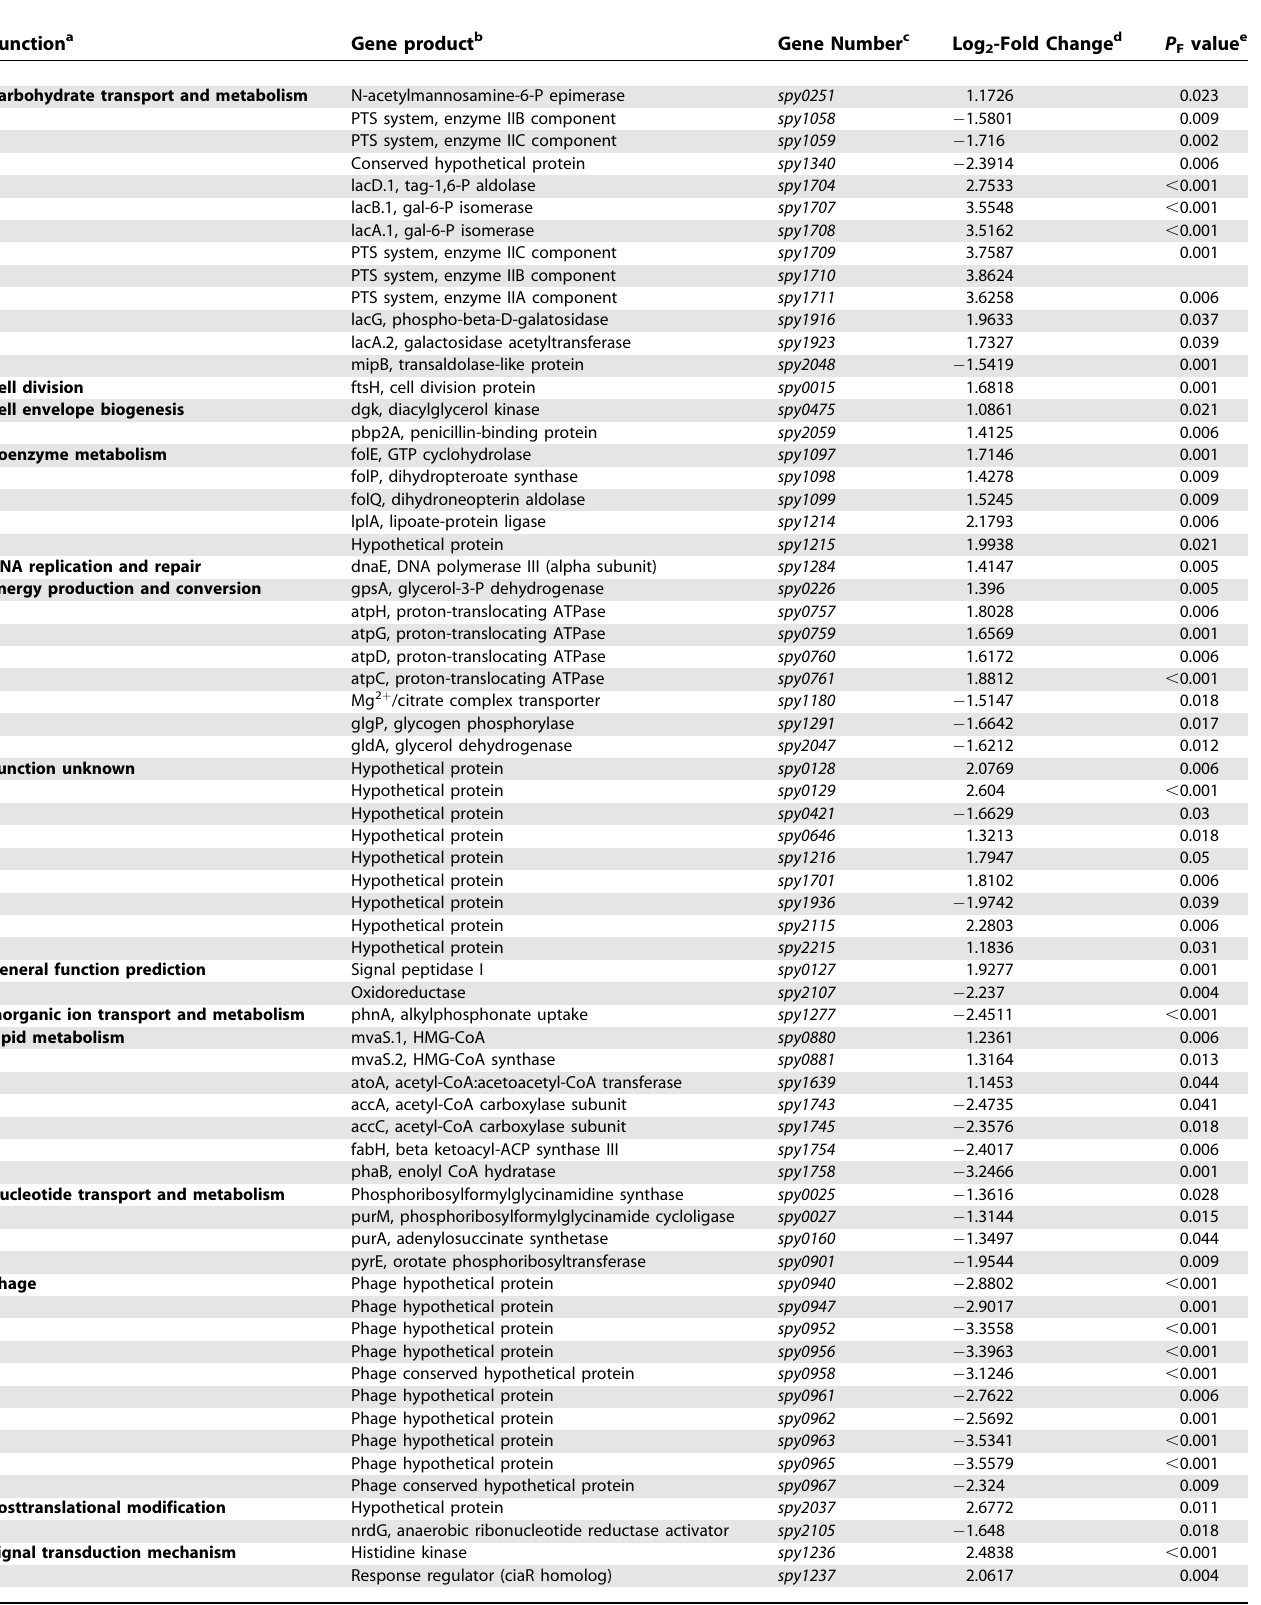
Table 1. Summary of Streptococcal Genes Exhibiting Significant Changes in Expression during Adherence to Pharyngeal Cells Compared with Associated Streptococcal Control